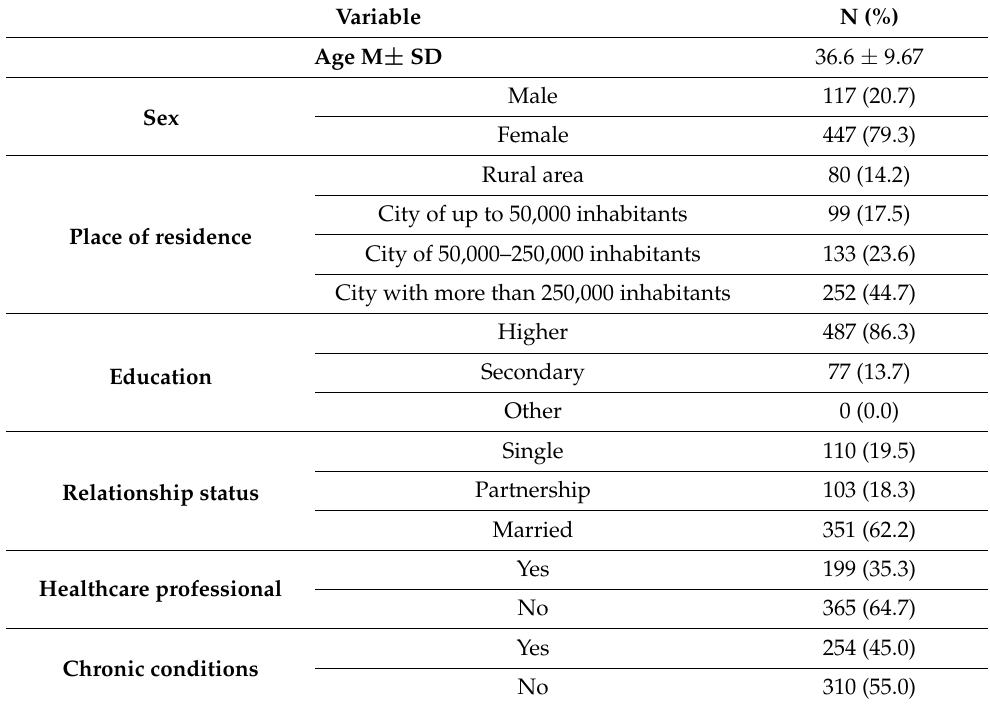
Table 1. Characteristics of the study